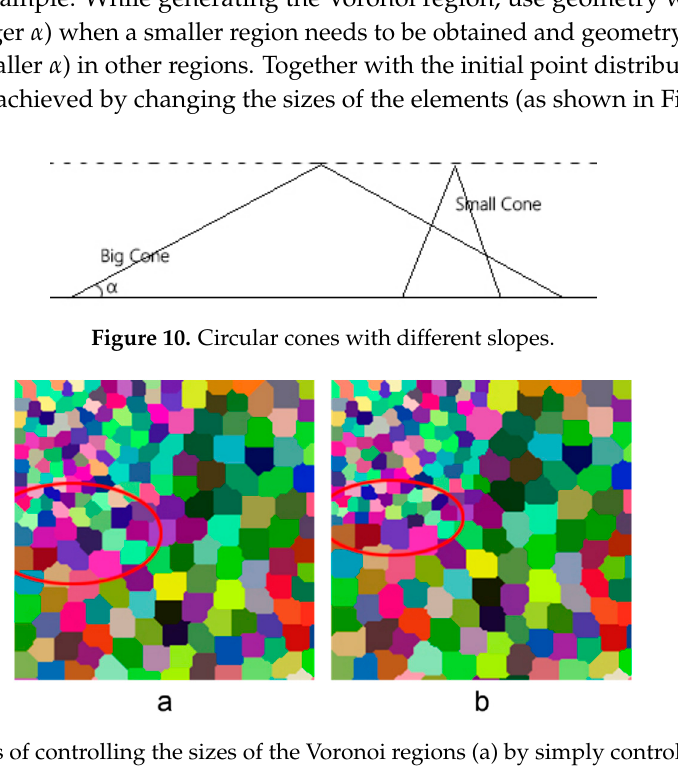
Figure 11. Results of controlling the sizes of the Voronoi regions (a) by simply controlling the initial point density and ( b ) by controlling the initial point density and geometric slopes.